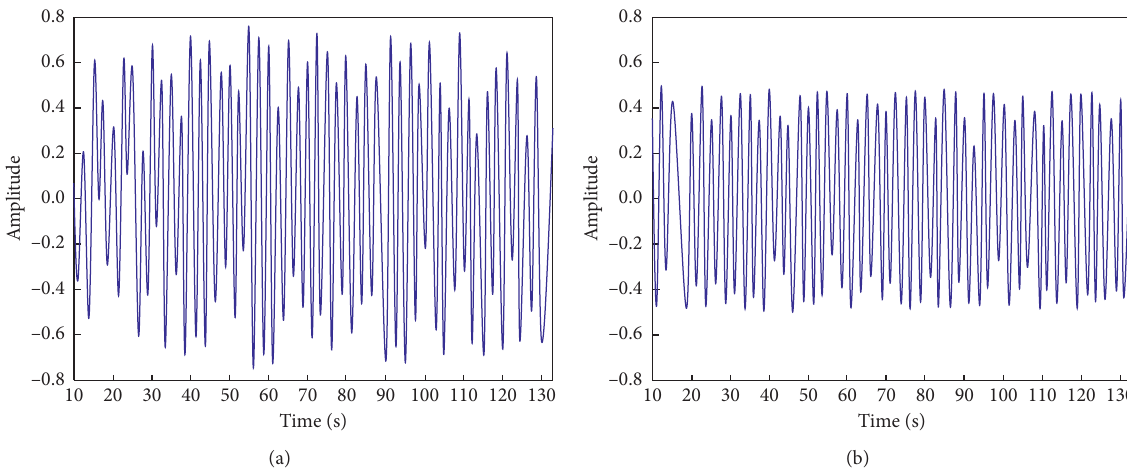
Figure 7: Economic chaotic time series based on chaotic genetics combined with fuzzy decision algorithm when the variable is true value (a) and predicted value